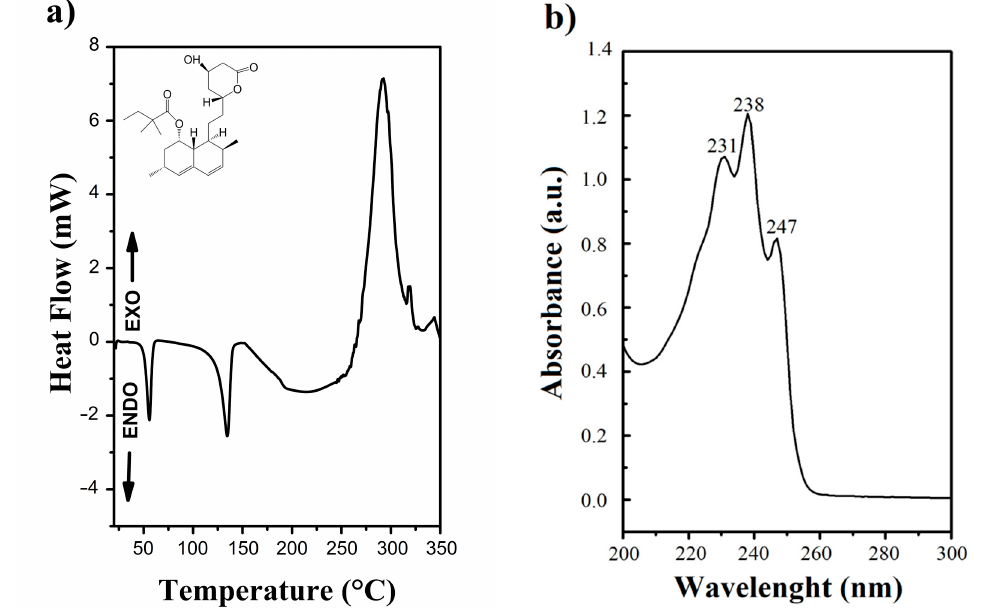
Figure 5. ( a ) Differential scanning calorimetry (DSC) and ( b ) Absorption spectra in the ultraviolet region of simvastatin (SIMV).